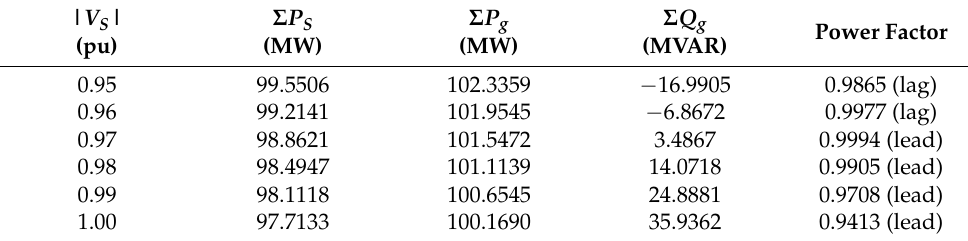
Table 11. Stator power, WPP output and power factor ( V w = 9 m/s).